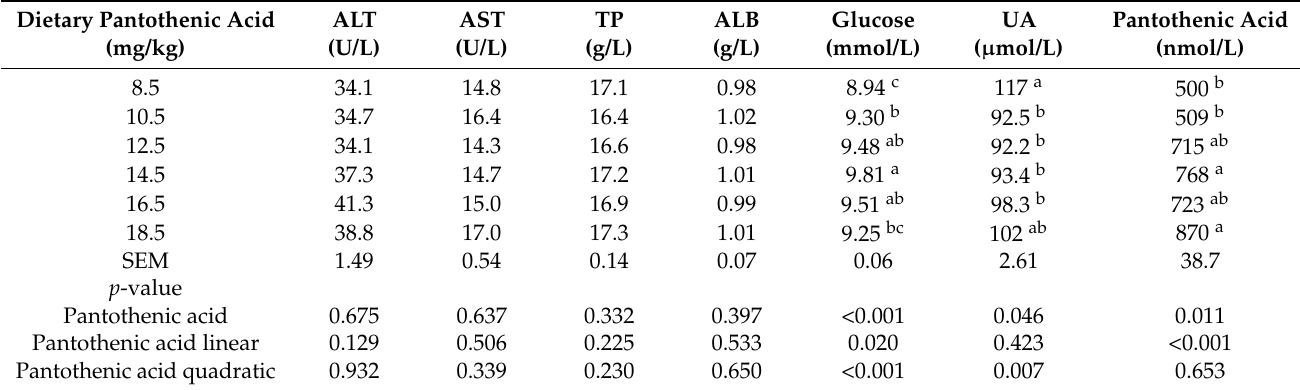
Table 5. Effect of dietary pantothenic acid levels on plasma biochemical parameters of the 21-day-old male white Pekin ducks 1 .